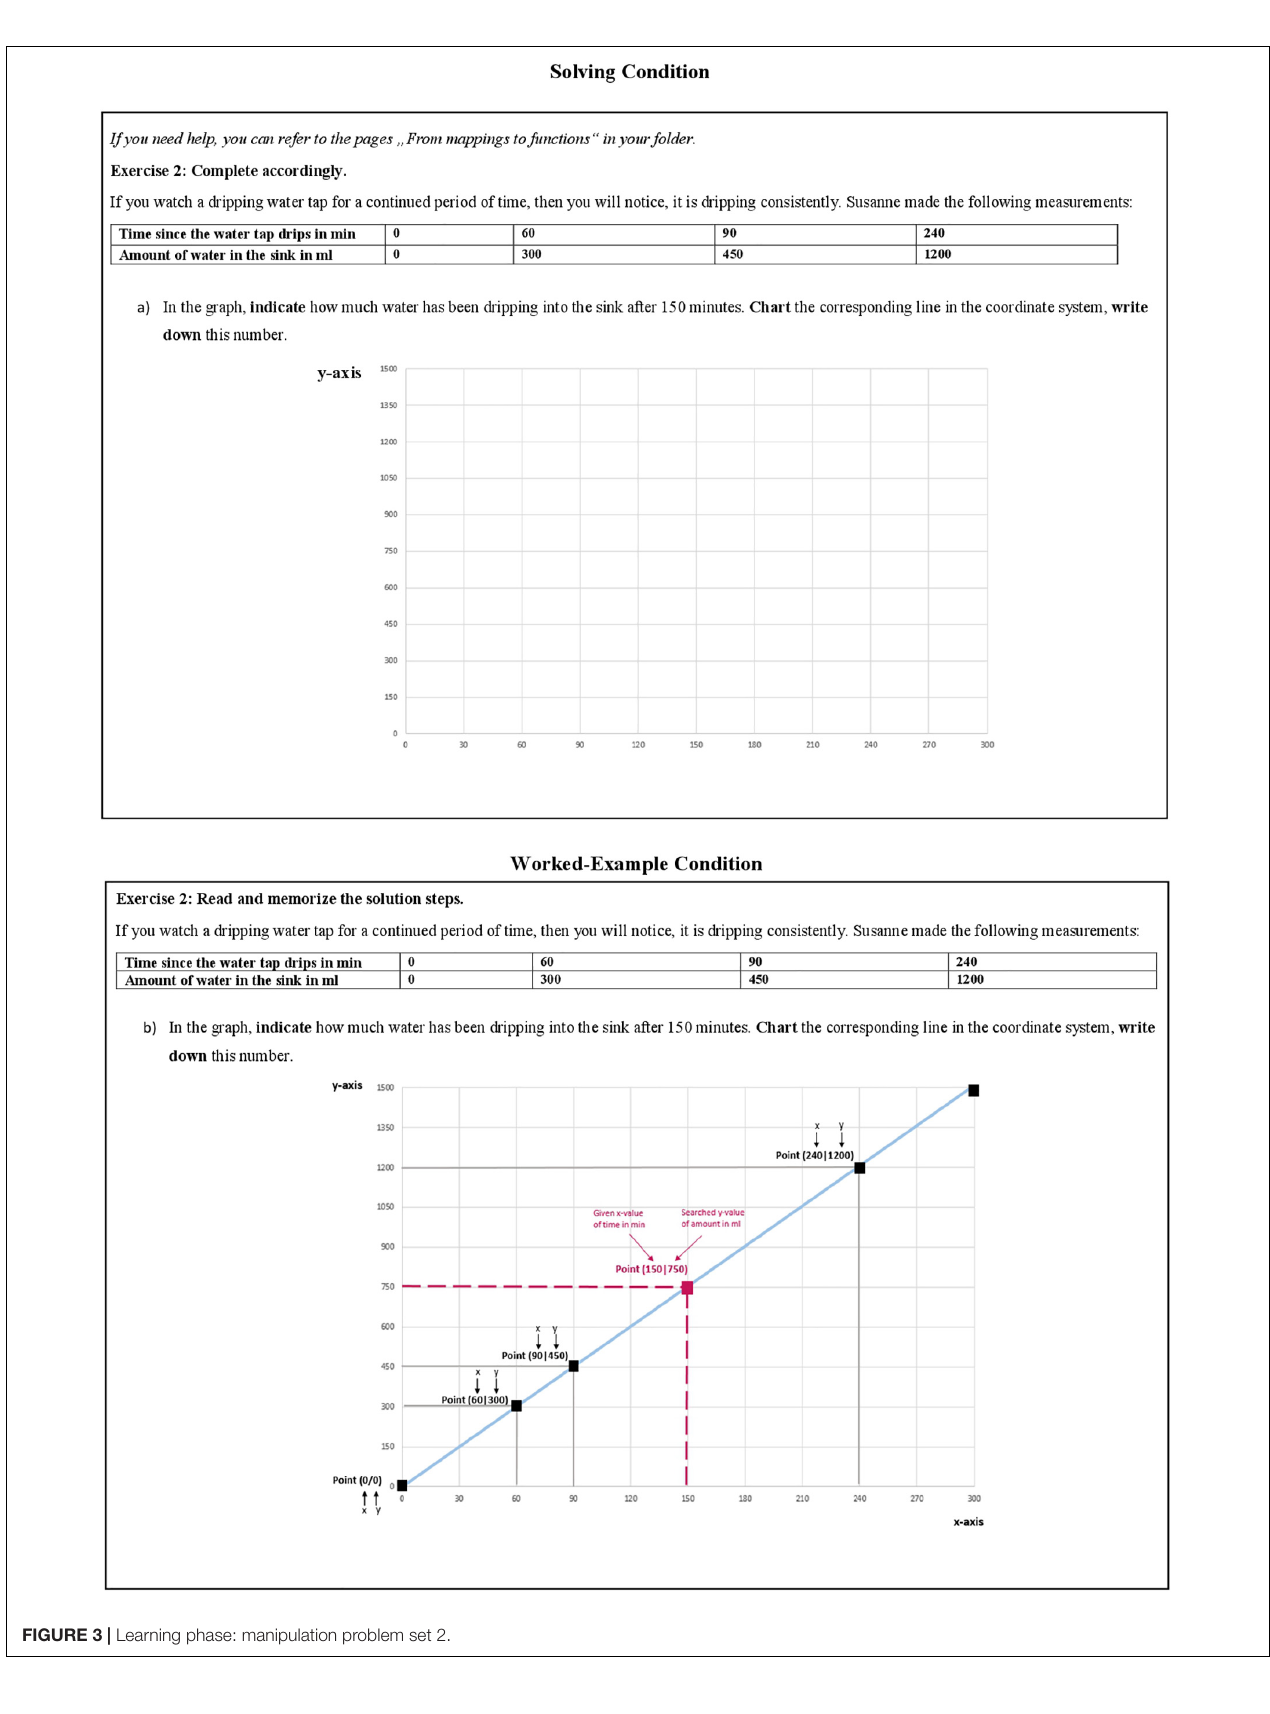
FIGURE 3 | Learning phase: manipulation problem set